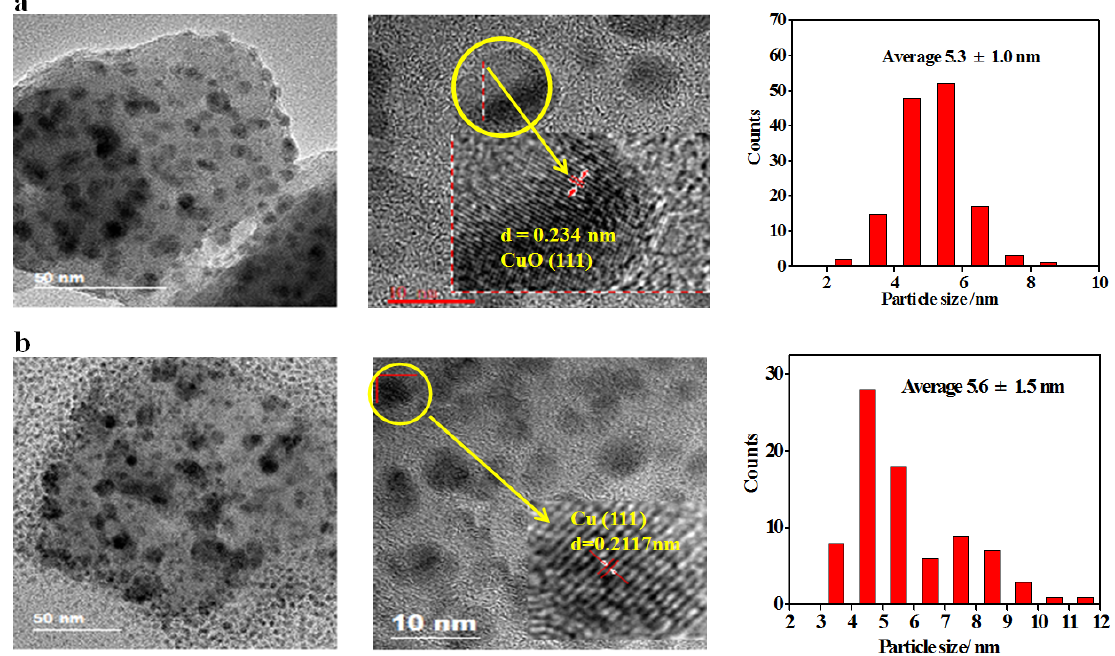
Figure 2. TEM and HRTEM images and particle size distributions of the calcined ( a ) and reduced ( b ) 25Cu–ASA-4 catalyst (reduction conditions: 300 °C for 30 min in the 10%H 2 /N 2 mixed gas).